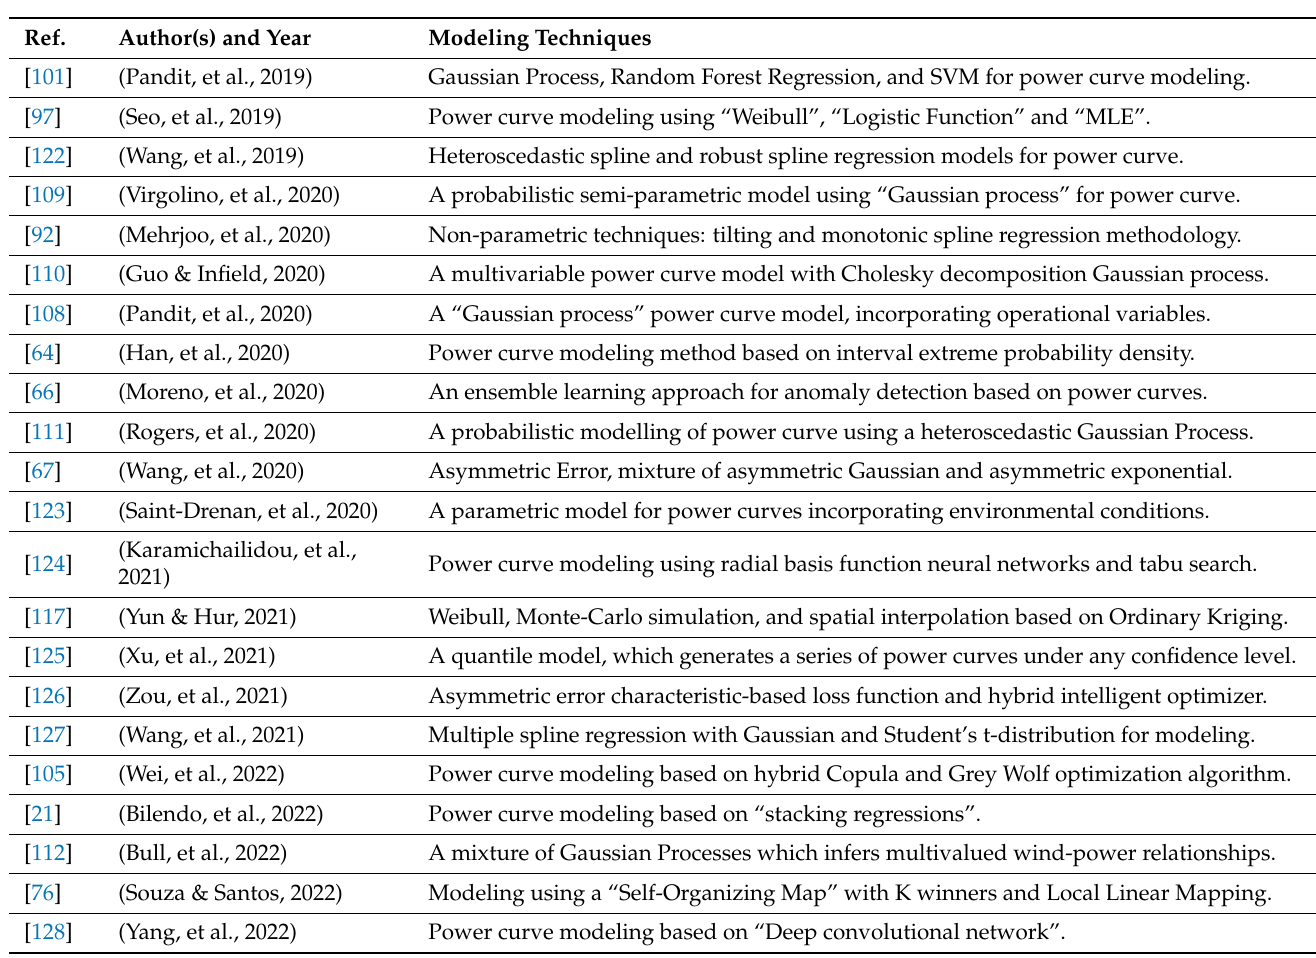
A probabilistic semi-parametric model using “Gaussian process” for power curve. Non-parametric techniques: tilting and monotonic spline regression methodology. A multivariable power curve model with Cholesky decomposition Gaussian process. A “Gaussian process” power curve model, incorporating operational variables. Power curve modeling method based on interval extreme probability density. An ensemble learning approach for anomaly detection based on power curves. A probabilistic modelling of power curve using a heteroscedastic Gaussian Process. Asymmetric Error, mixture of asymmetric Gaussian and asymmetric exponential. A parametric model for power curves incorporating environmental conditions. Power curve modeling using radial basis function neural networks and tabu search. Weibull, Monte-Carlo simulation, and spatial interpolation based on Ordinary Kriging. A quantile model, which generates a series of power curves under any confidence level. Asymmetric error characteristic-based loss function and hybrid intelligent optimizer. Multiple spline regression with Gaussian and Student’s t-distribution for modeling. Power curve modeling based on hybrid Copula and Grey Wolf optimization algorithm. Power curve modeling based on “stacking regressions”. A mixture of Gaussian Processes which infers multivalued wind-power relationships. Modeling using a “Self-Organizing Map” with K winners and Local Linear